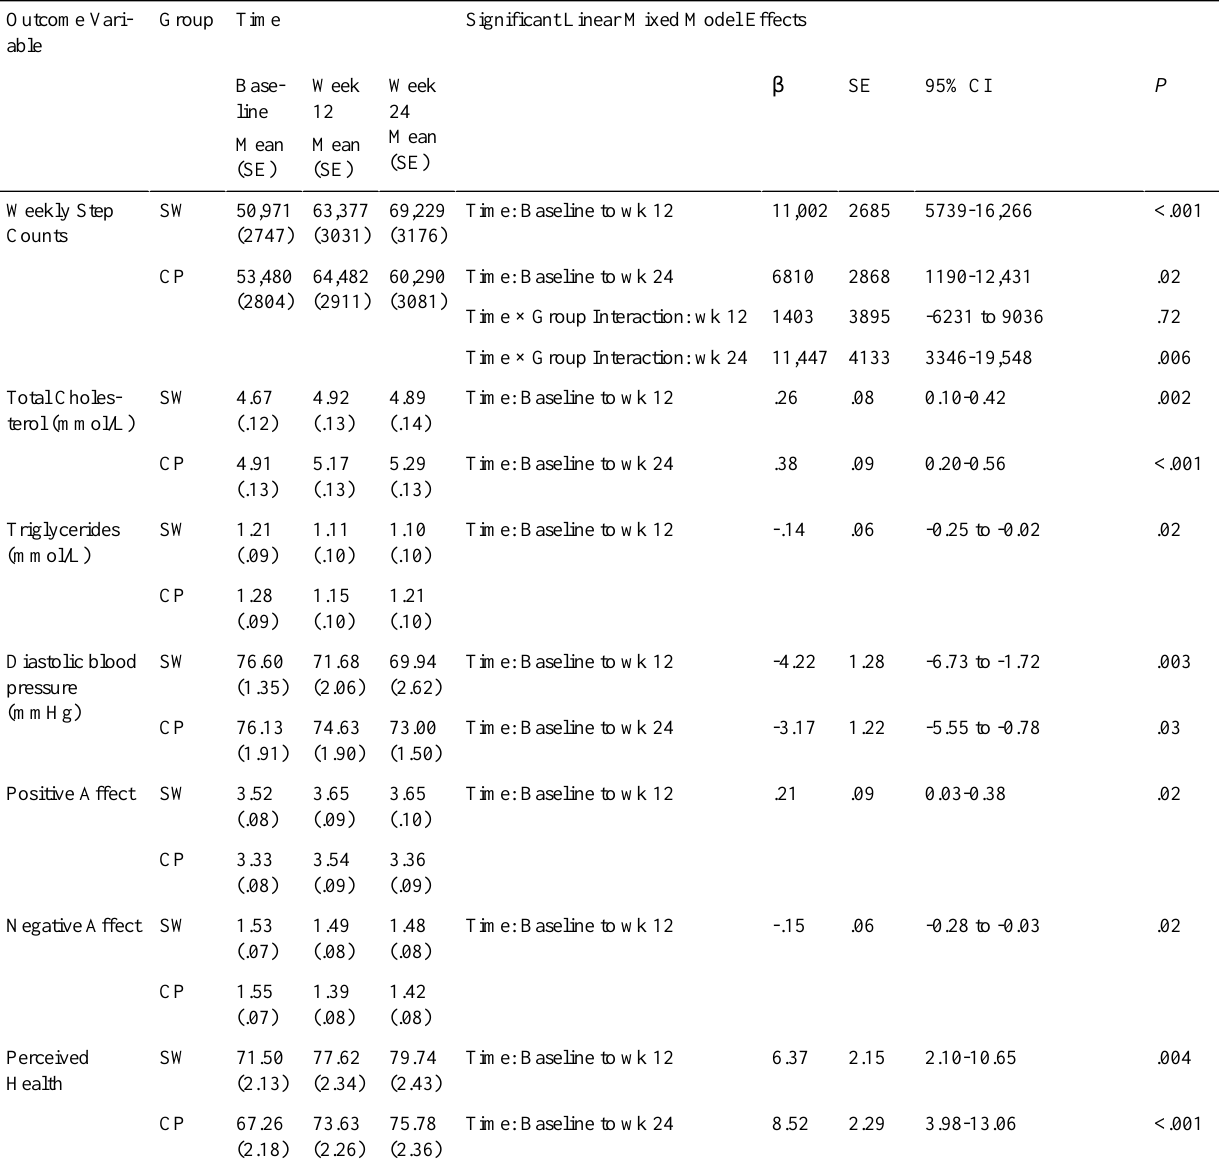
Table 2. Results of the step count and health data for the StepWise (SW) and Comparison (CP) groups at baseline, 12, and 24 weeks.